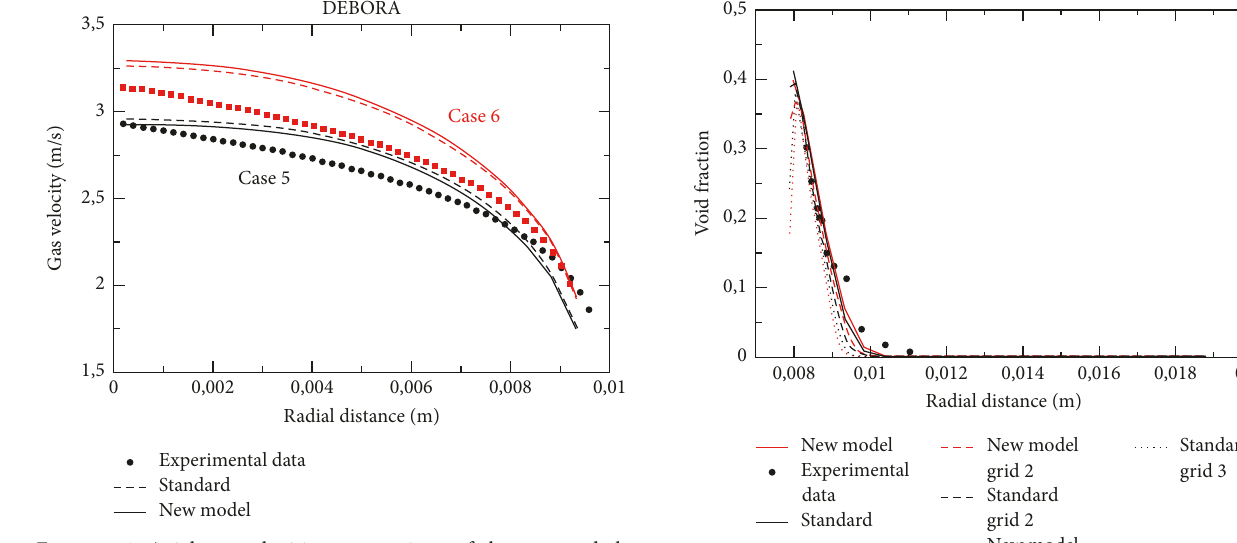
Figure 54: Axial gas velocities, comparison of the new and the previous model for cases 5 (black) and 6 (red).